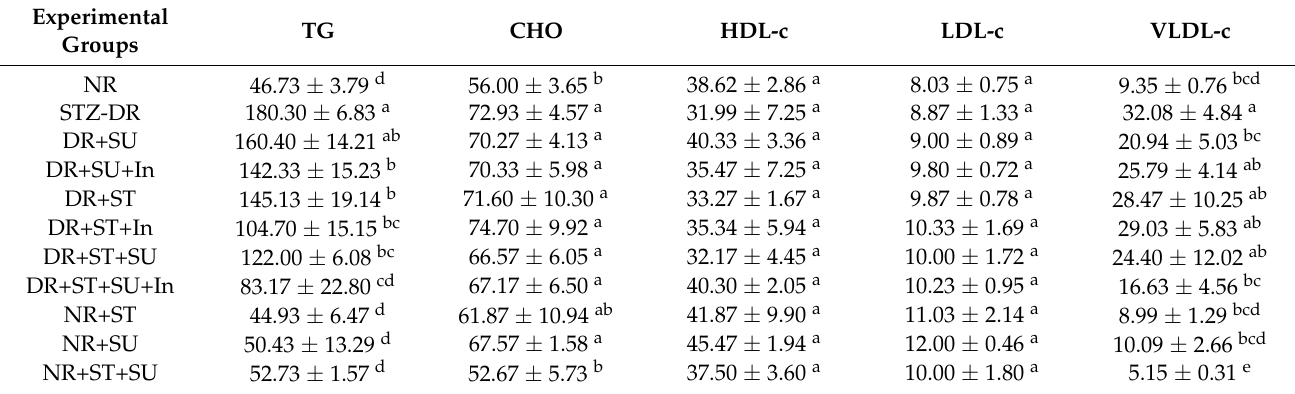
Table 3. Effects of stevioside and sucralose and their combination on the lipid profile (mg dL − 1 ) in STZ-induced diabetes in rats, n =